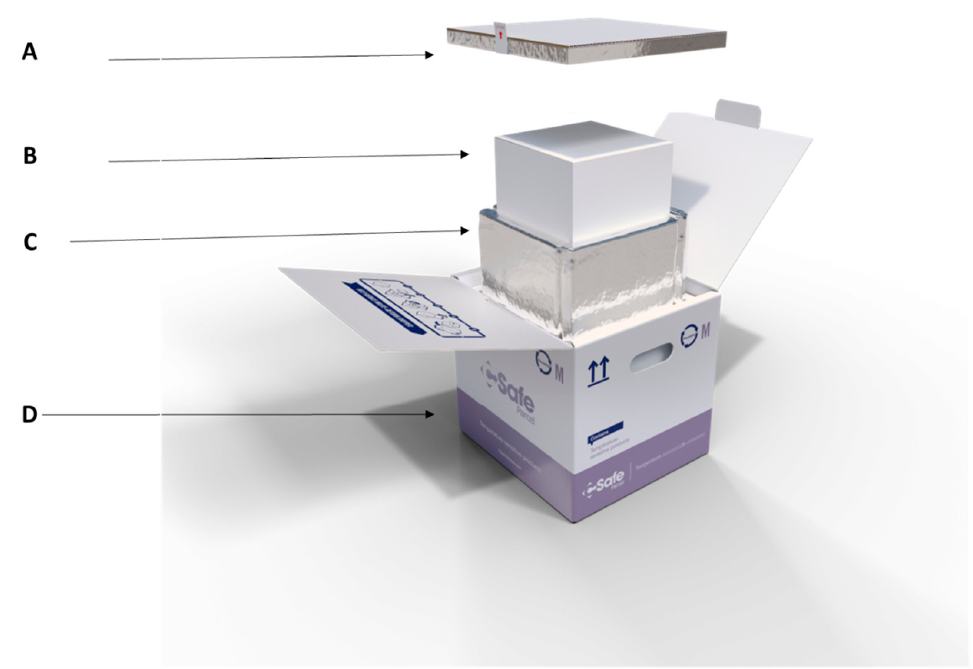
Figure 1. Assembly of the packing box (mass transport box) including the lid ( A ), the inner carton (small carton) ( B ), the outer carton (big carton vacuum insulated box) ( C ) and an external protection ( D ) (csafeglobal.com).